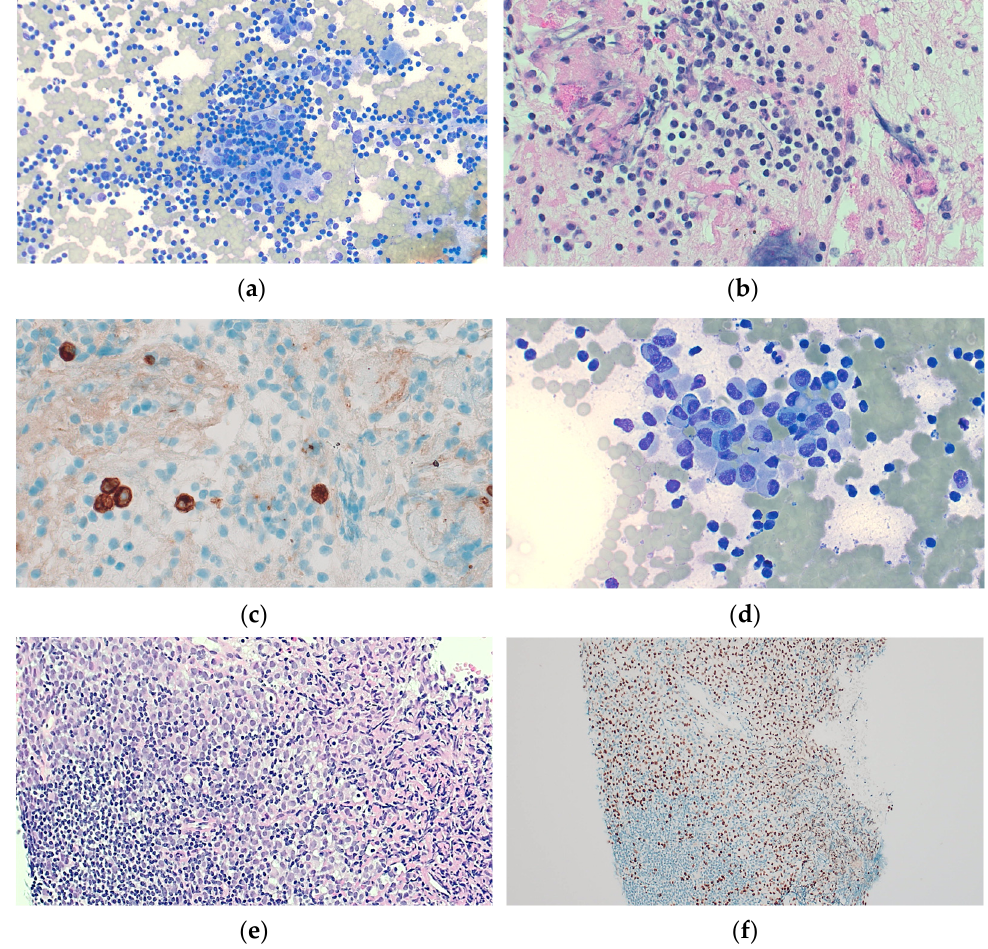
Figure 14. ( a ) FNAB of one of multiple enlarged nodes was interpreted initially as benign reactive changes. DQ ×100. The cell block, H&E ×100 ( b ) shows cells with subtle rounded, minimally enlarged nuclei which were confirmed to be cytokeratin—positive on immunostaining for cytokeratins ( c ) (AE1/AE3 ×200). ( d ) In retrospect, there were atypical cells on the smear, DQ ×200. ( e ) Core biopsy confirmed metastatic lobular carcinoma, H&E ×100, with ER immunostaining in ( f ) ×40.